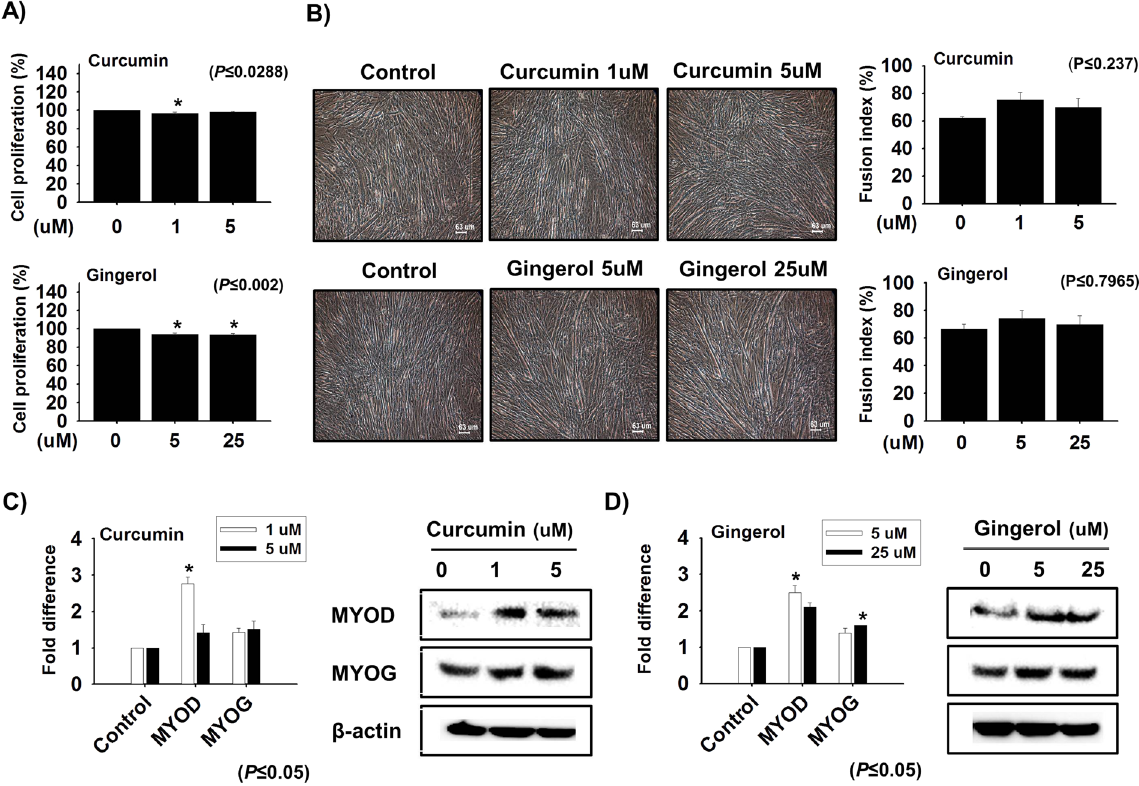
Figure 4. Effect of curcumin and gingerol on cellular differentiation. ( A ) Cell proliferations in the presence of different concentrations of curcumin (1 or 5 µ M) or gingerol (5 or 25 µ M). ( B ) Effects of curcumin or gingerol on myotube formation and fusion indices. ( C and D ) MYOD and MYOG expression determination by real time PCR and Western blot after treating cells with different concentrations of curcumin or gingerol (n =